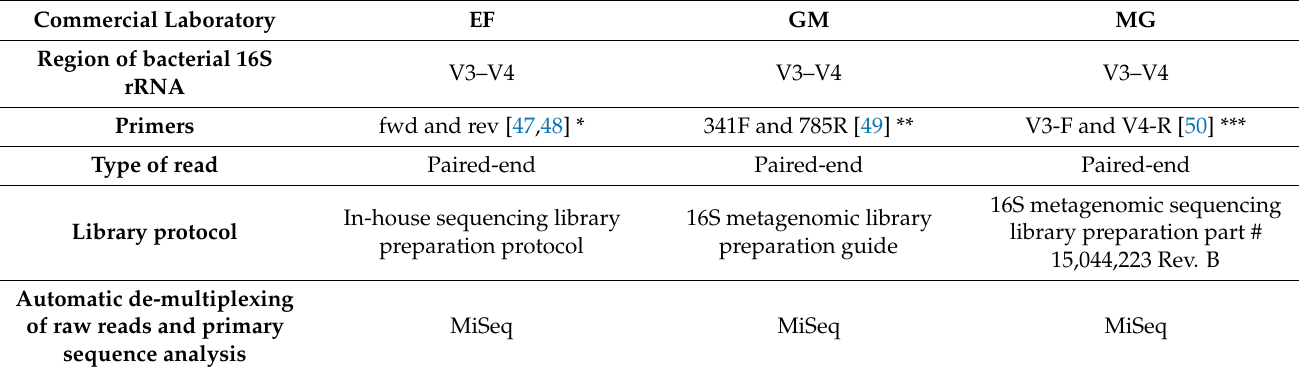
Table 2. Comparison of the HTS methodology used by commercial